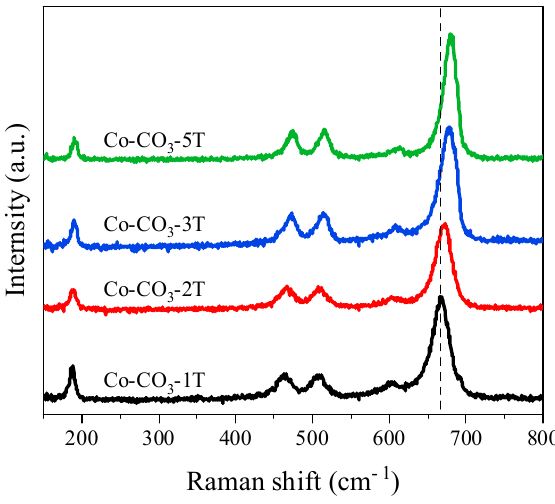
Figure 3. Raman spectra of the catalysts.